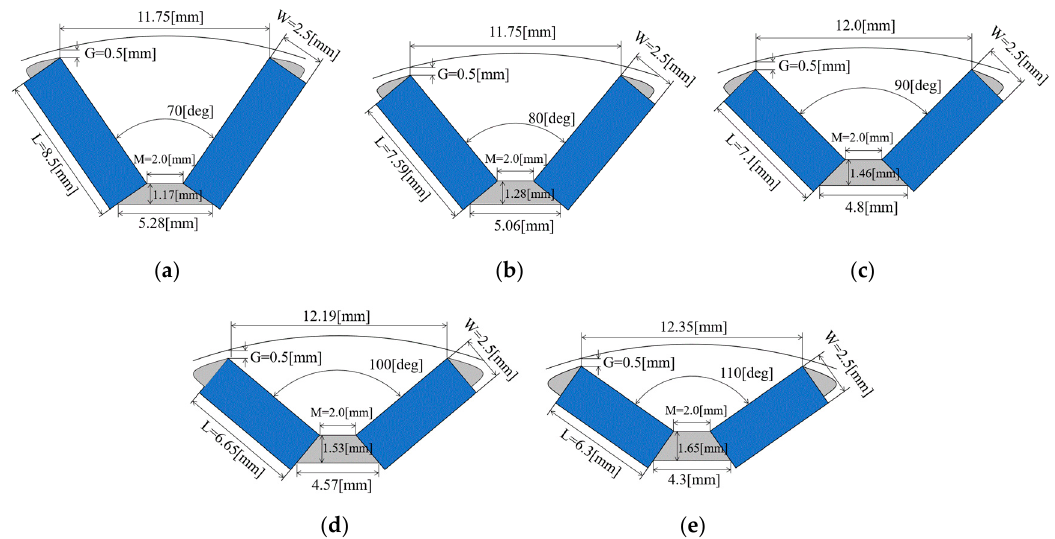
Figure 6. The geometric shapes of each model: ( a ) 70 degrees, ( b ) 80 degrees, ( c ) 90 degrees, ( d ) 100 degrees, ( e ) 110 degrees.